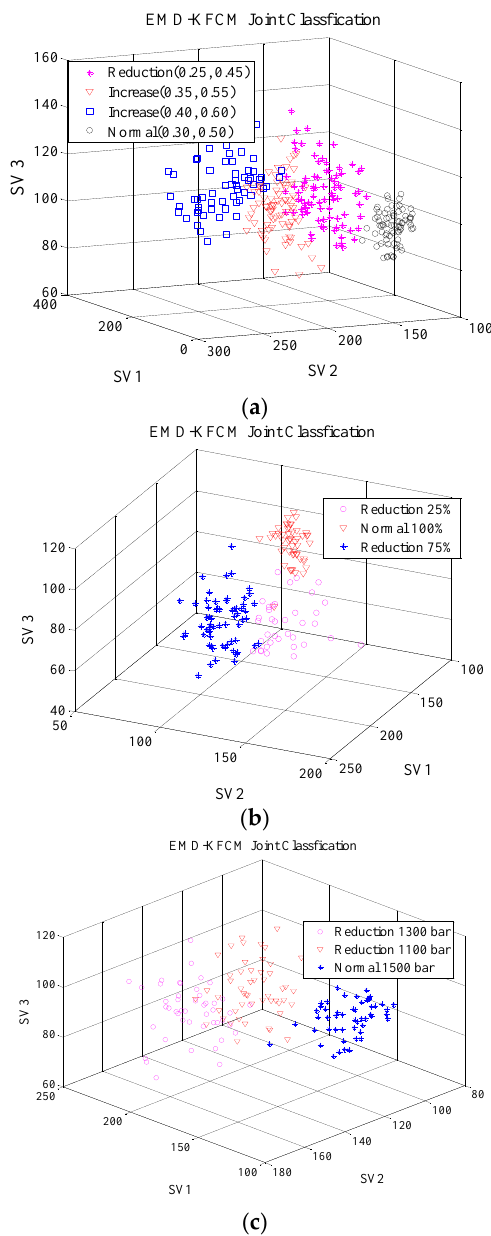
Figure 15. EMD-KFCM classification results: ( a ) classification result of abnormal valve clearance; ( b ) classification result of insufficient fuel supply signals; and ( c ) classification result of abnormal common rail pressure signals.